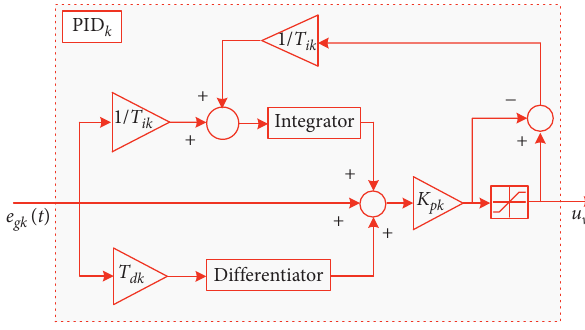
Figure 7: Antiwindup PID controller structure of k th OWC